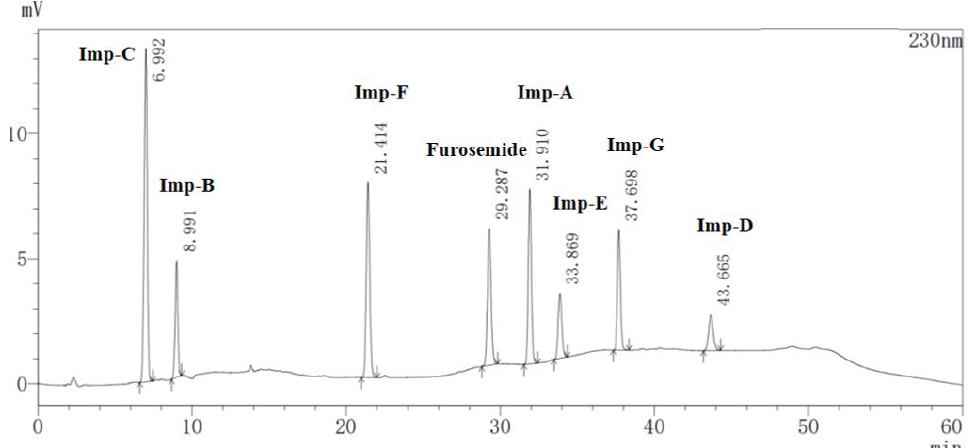
Figure 5. HPLC chromatogram of the specificity solution. The retention times for furosemide and impurity A – G: furosemide, 29.287 min; impurity C, 6.992 min; impurity B, 8.991 min; impurity F, 21.414 min; impurity A, 31.910 min; impurity E, 33.869 min; impurity G, 37.698 min; impurity D, 43.665 min.